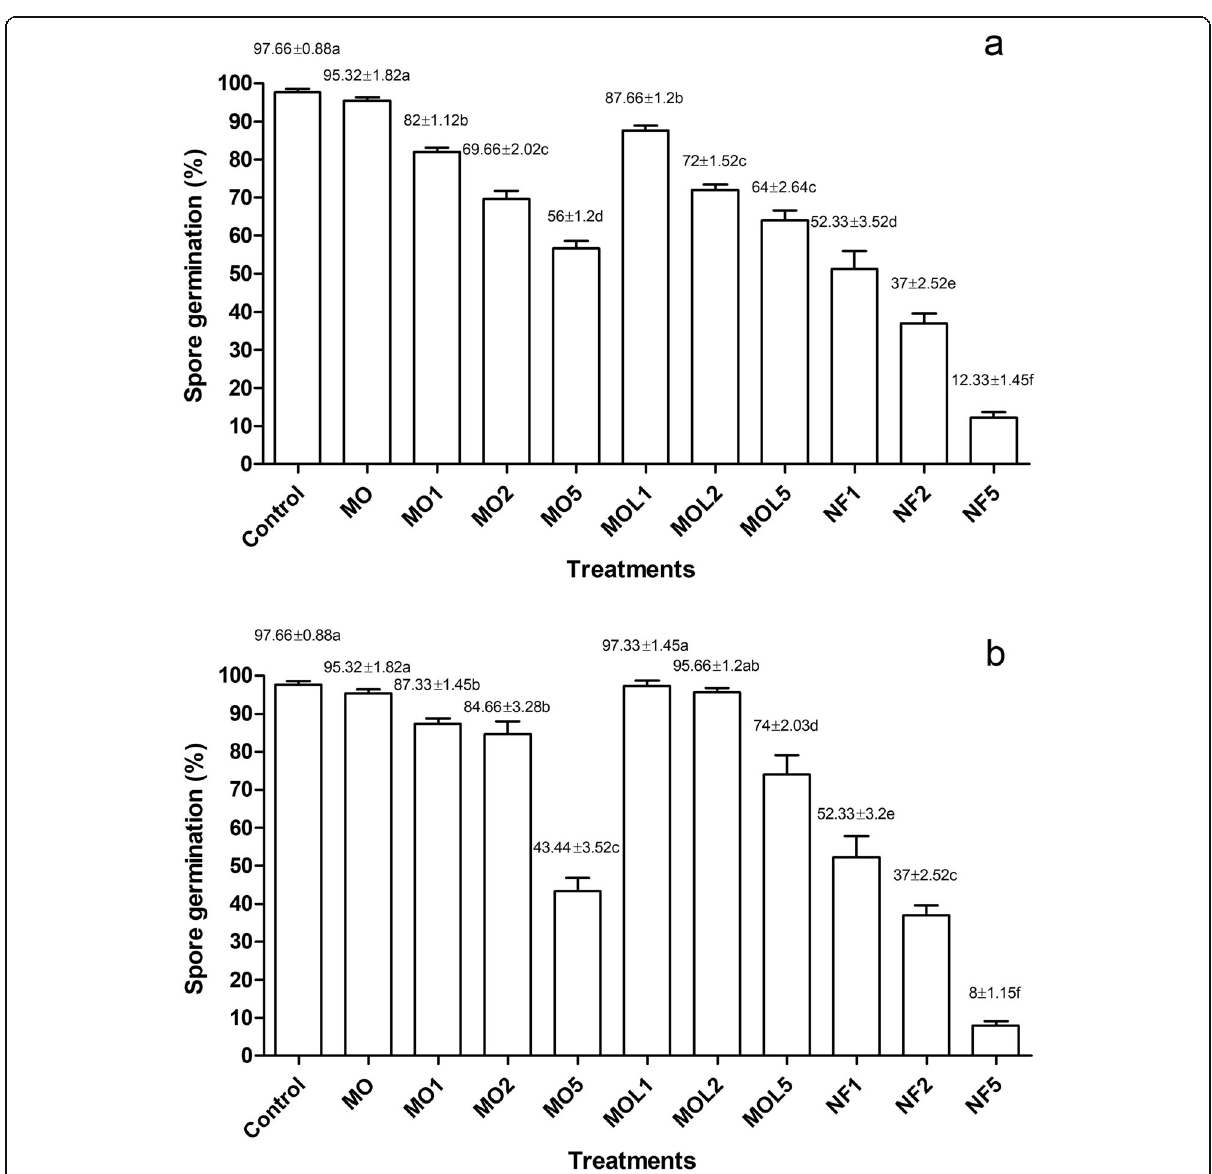
Fig. 1 Viability of Trichoderma asperellum spores in formulations with mineral oil (MO) and exposed to UVR. a Spores in MO + UV-C. b Spores in MO + UV-B. MO, spores + MO without UVR; MOL, MO + lignosulfonate without UVR; NF, no formulation. Numbers in each treatment indicate exposure time to UVR (minutes). Letters indicate statistical differences ( P <